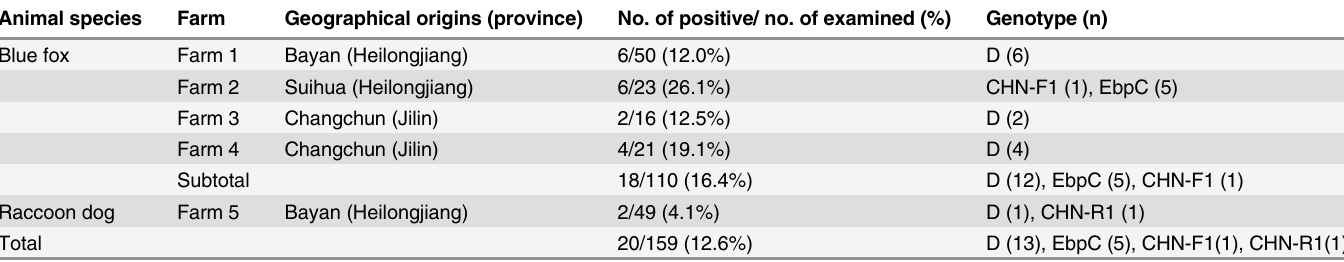
Table 1. Prevalence and genotypes of E . bieneusi in blue foxes and raccoon dogs. Animal species